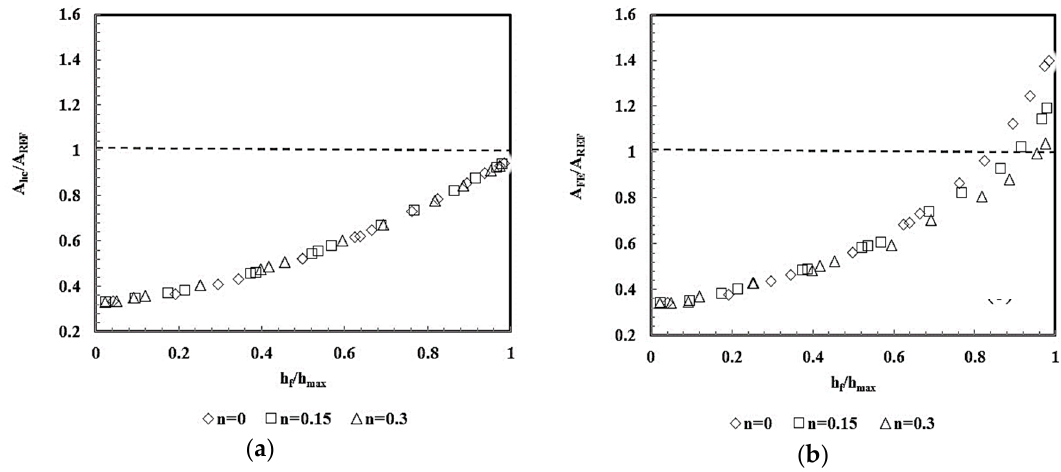
Figure 8. Normalized contact area results obtained in the numerical simulation of the materials with the values of the strain hardening parameter, yield stress and Young’s modulus shown in Table 2, using the Knoop indenter. ( a ) Contact area A h / A REF ; ( b ) Contact area A FE / A REF